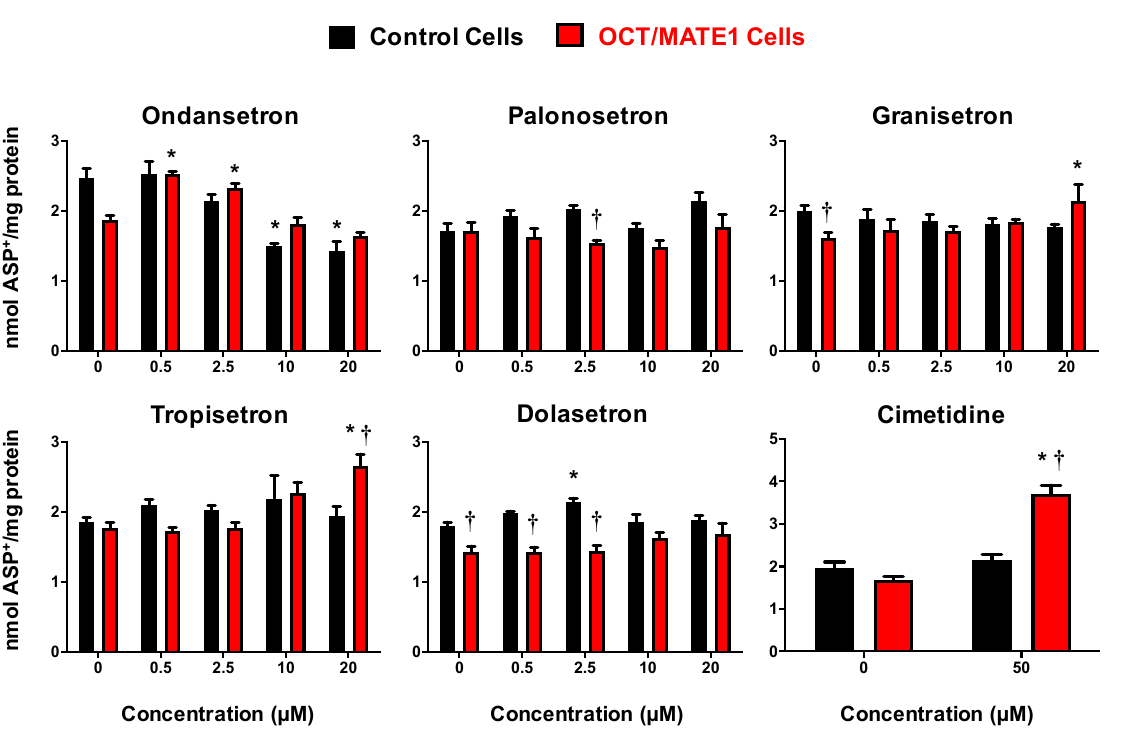
Figure 6. Intracellular Accumulation of ASP + in OCT2/MATE1-Transfected MDCK Cells after 5-HT 3 Antagonist Treatment. Empty vector (black bars) and OCT2/MATE1-transfected (red bars) MDCK cells were incubated with ASP + (25 µ M) in basolateral media with or without 5-HT 3 antagonists (0.5–20 µ M) or 50 µ M cimetidine in apical and basolateral media for 120 min. Intracellular fluorescence (120 min) was quantified and normalized to protein concentration. Data are expressed as mean ± SE ( n = 3). * p < 0.05 compared to no inhibitor. † p < 0.05 compared to empty vector control cells.